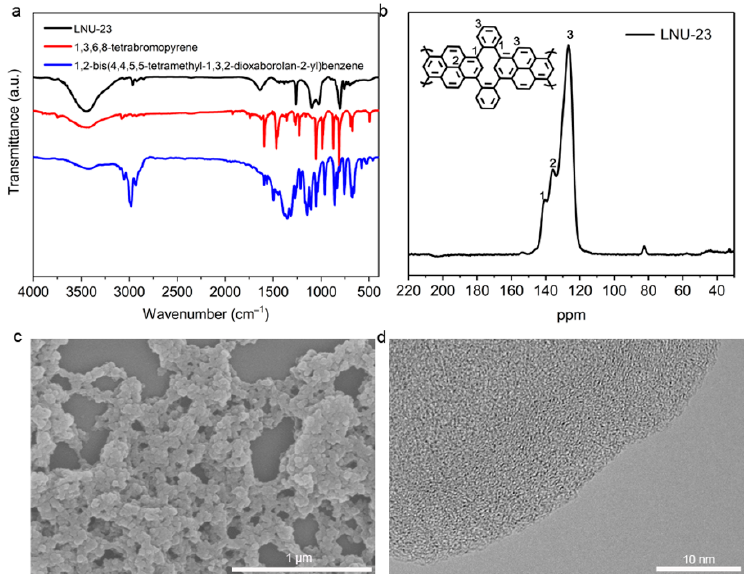
Figure 2. ( a ) FTIR spectra of LNU-23 and raw materials; ( b ) solid-state 13 C NMR spectrum of LUN-23; ( c ) SEM and ( d ) TEM images of LNU-23.